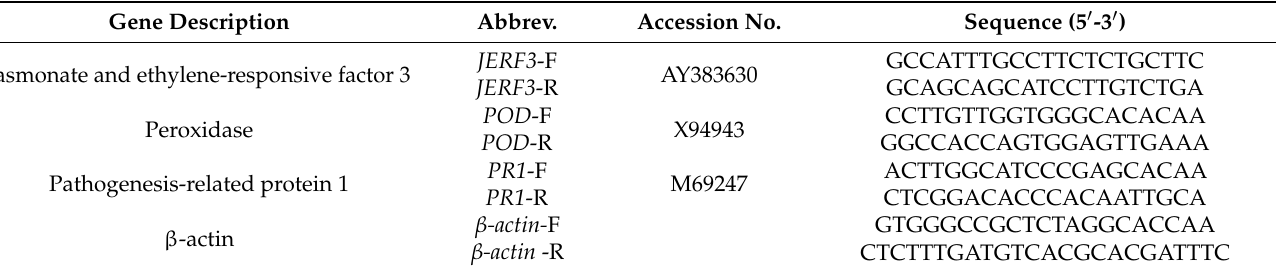
Table 6. Primer sequences used in the molecular